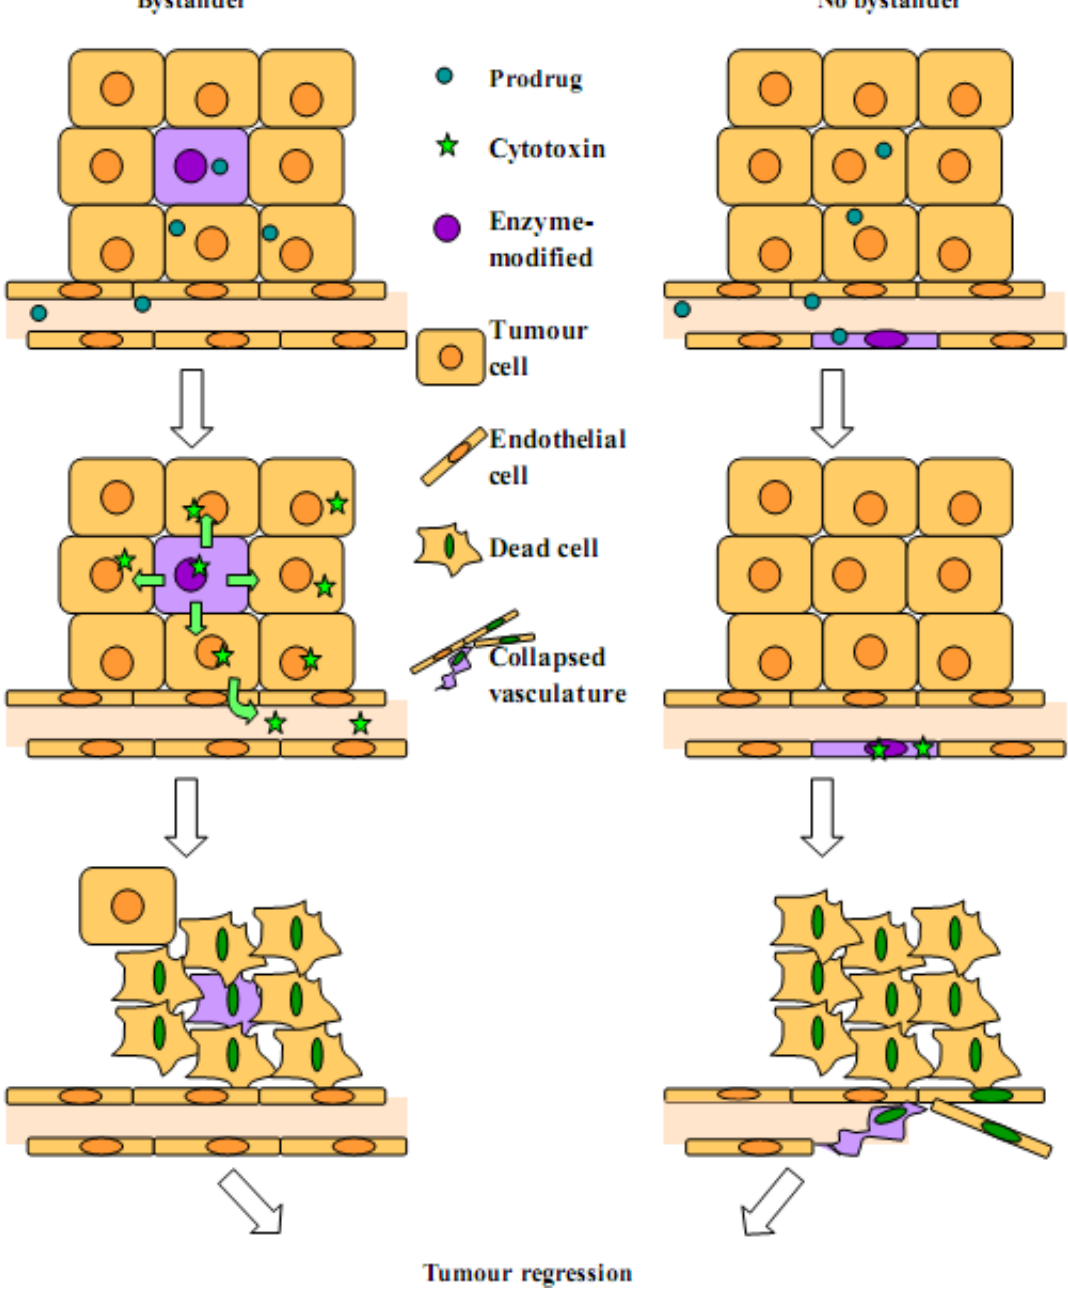
Figure 1. Gene directed enzyme prodrug therapy (GDEPT). Gene delivery to tumour